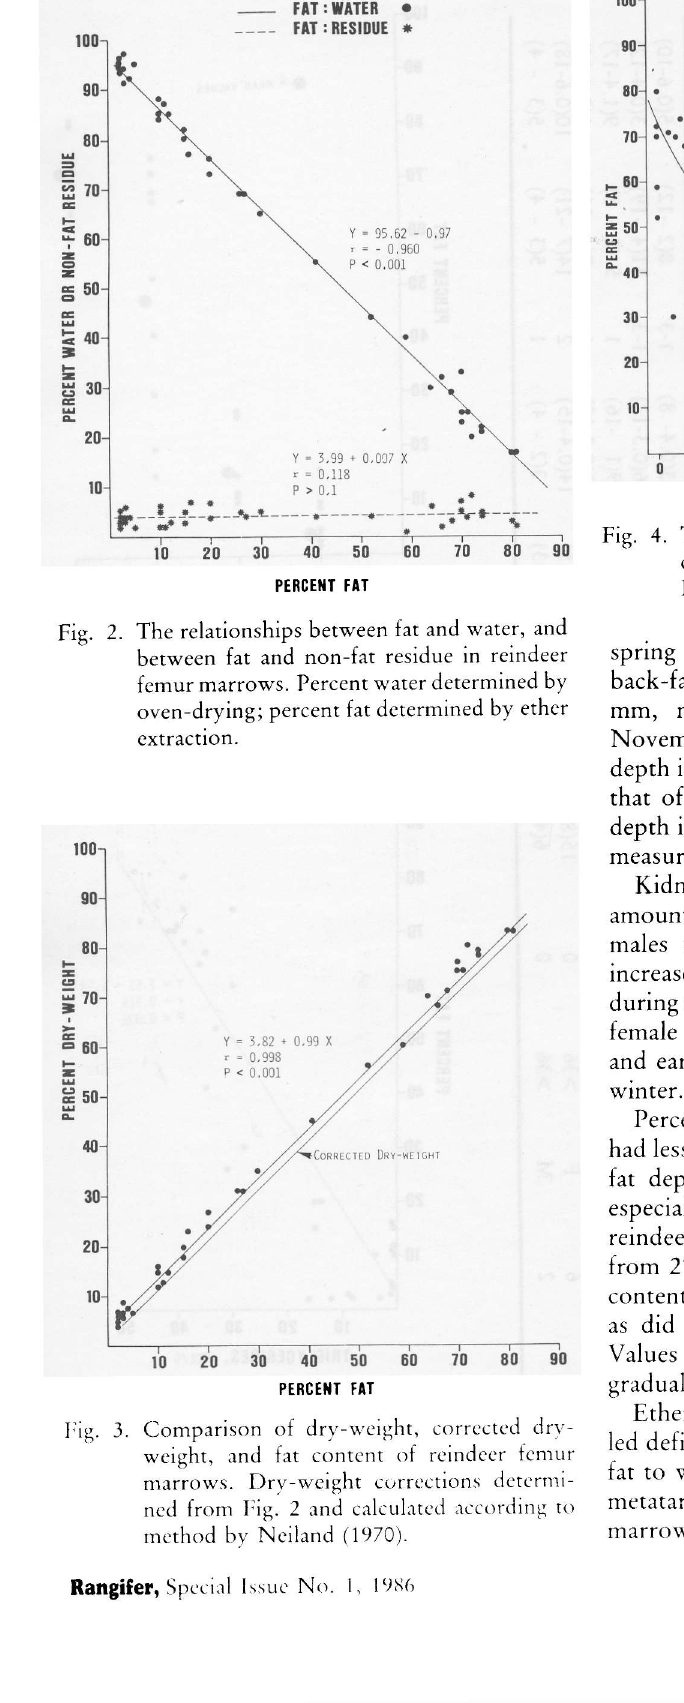
Fig. 3. Comparison of dry-weight, corrected dry- weight, and fat content of reindeer femur marrows. Dry-weight corrections determi ned from Fig. 2 and calculated according to method by Neiland (1970).